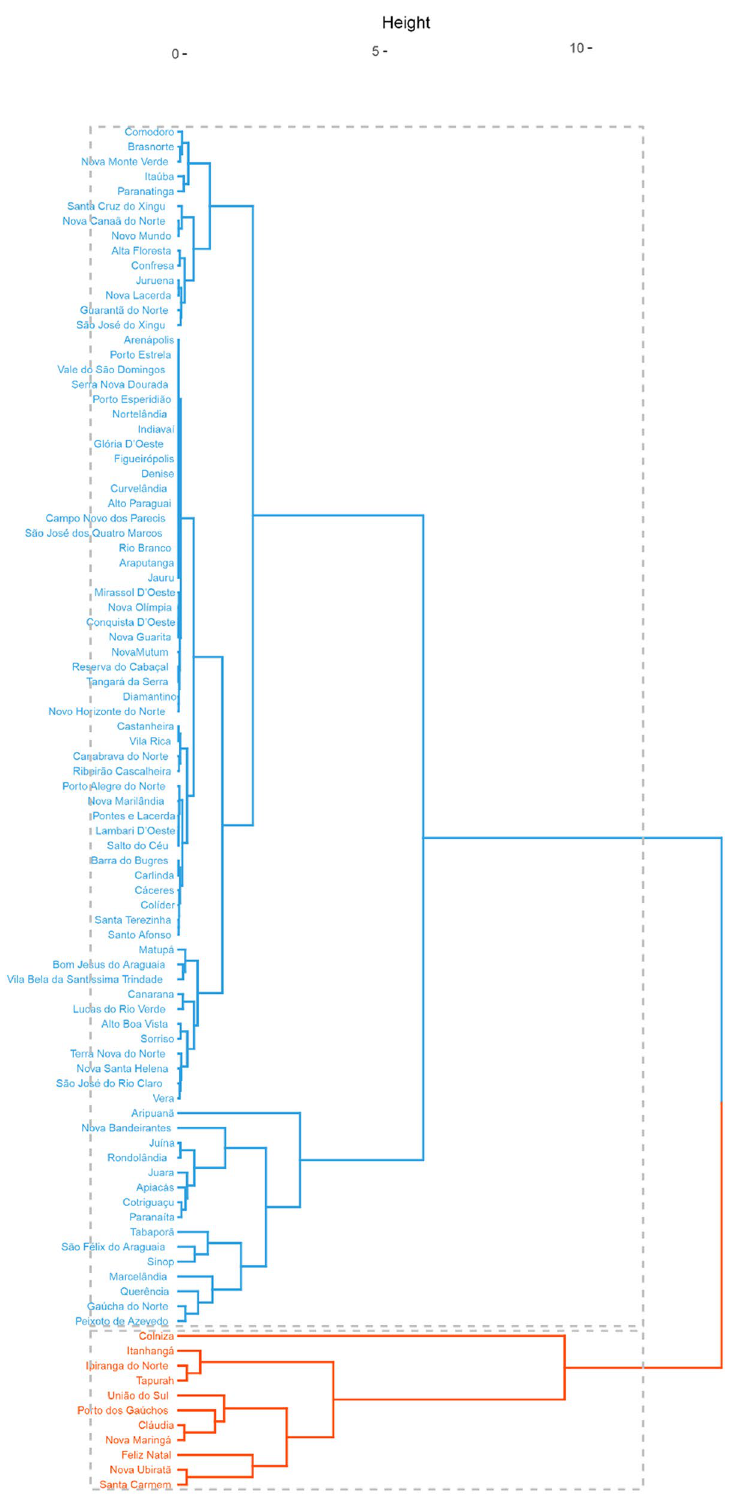
Figure 9. Cluster analysis of the municipalities of Mato Grosso based on the data of total deforestation and deforestation for soybean cultivation obtained by the ImazonGeo